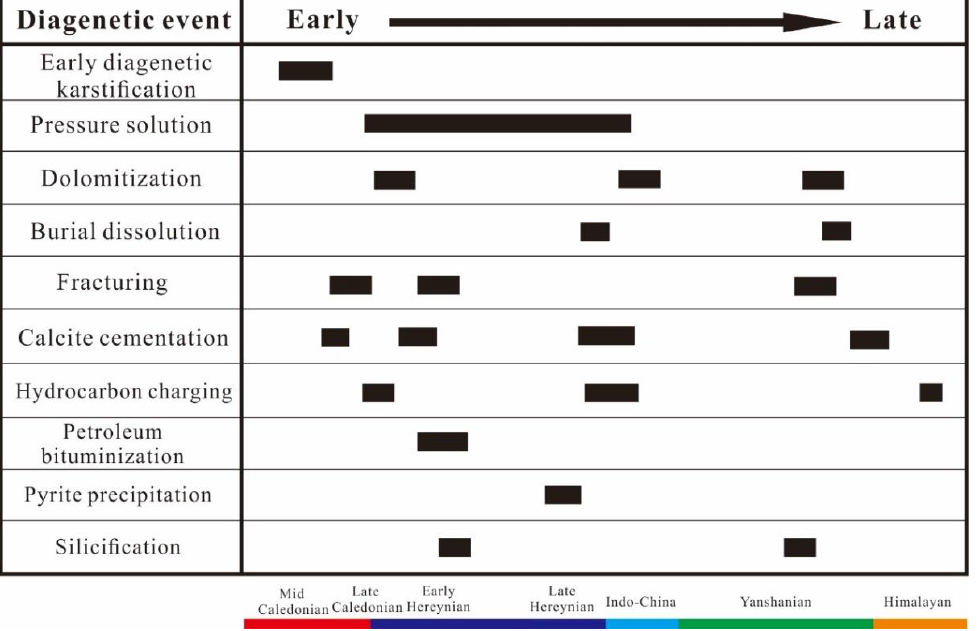
Figure 4. Diagenetic evolution of the carbonates of the Shunbei area.